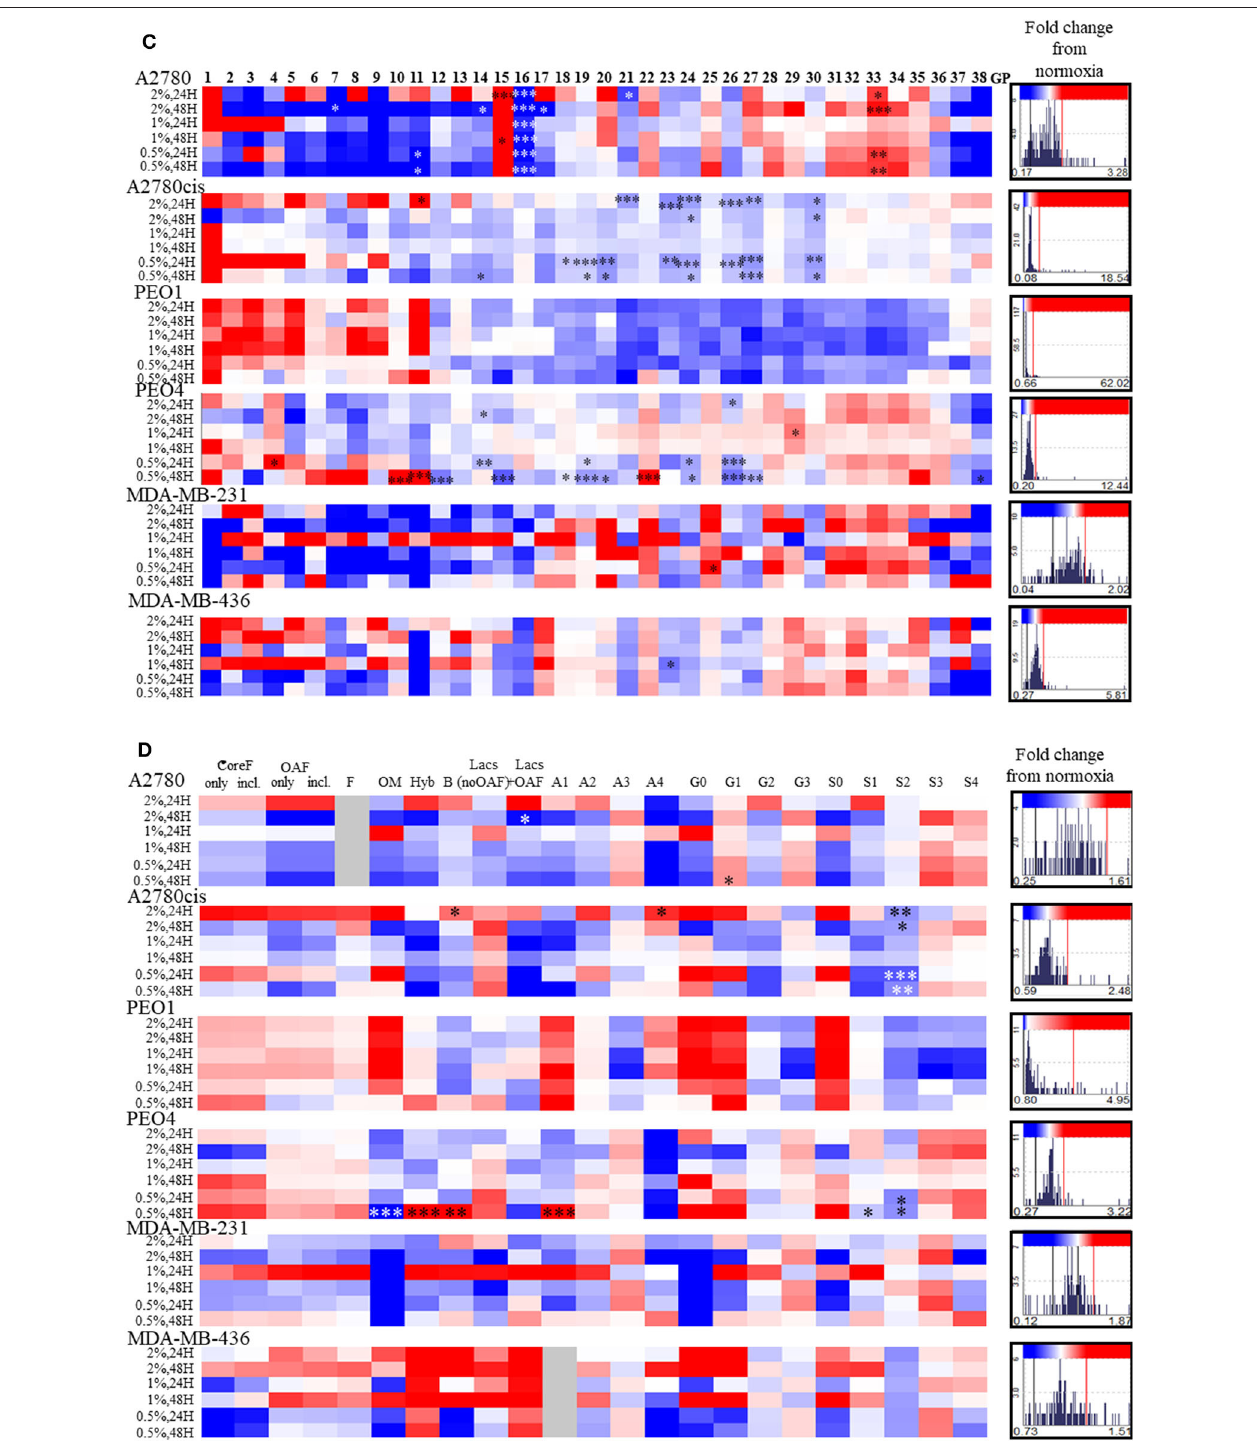
FIGURE 2 | Glycosylation in hypoxia. (A) Typical UPLC chromatograms of secreted N -glycome separated into 38 peaks from ovarian chemosensitive (in blue), chemoresistant (in orange) and triple negative breast cancer (TNBC) (in red) cells. Highly branched and sialylated glycans are highlighted in green. (B) Main glycans in each peak. Structure abbreviations: All N -glycans have two core GlcNAcs; F at the start of the abbreviation indicates a core-fucose α 1,6-linked to the inner GlcNAc; Mx, number of mannose on core GlcNAcs; Ax, number of antenna (GlcNAc) on trimannosyl core; A2, biantennary with both GlcNAcs as β 1,2-linked; A3, triantennary with a GlcNAc linked β 1,2 to both mannose and the third GlcNAc linked β 1,4 to the α 1,3 linked mannose; A3’, isomer with the third GlcNAc linked β 1-6 to the α 1-6